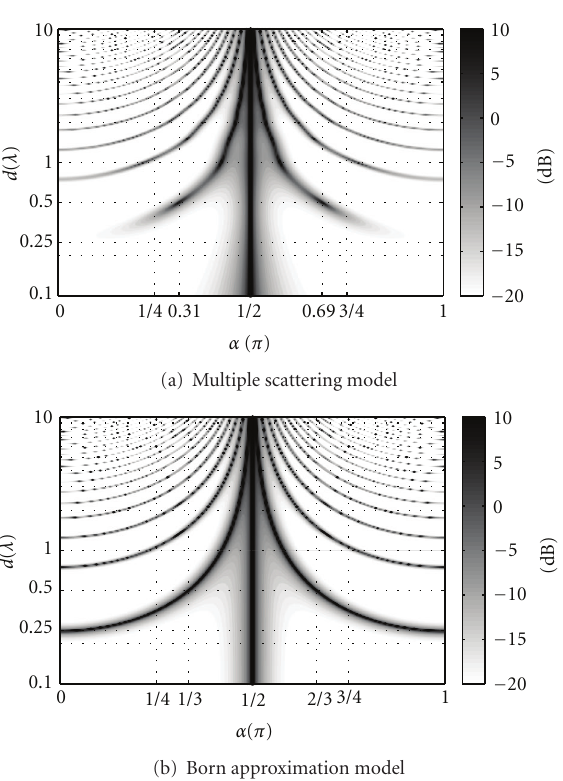
Figure 6: Contour plots of CRB( d 1 ) normalized by σ 2 correspond- ing to backscattering data for τ 1 = 1 = τ 2 versus the incidence angle α and scatterers’ separation d